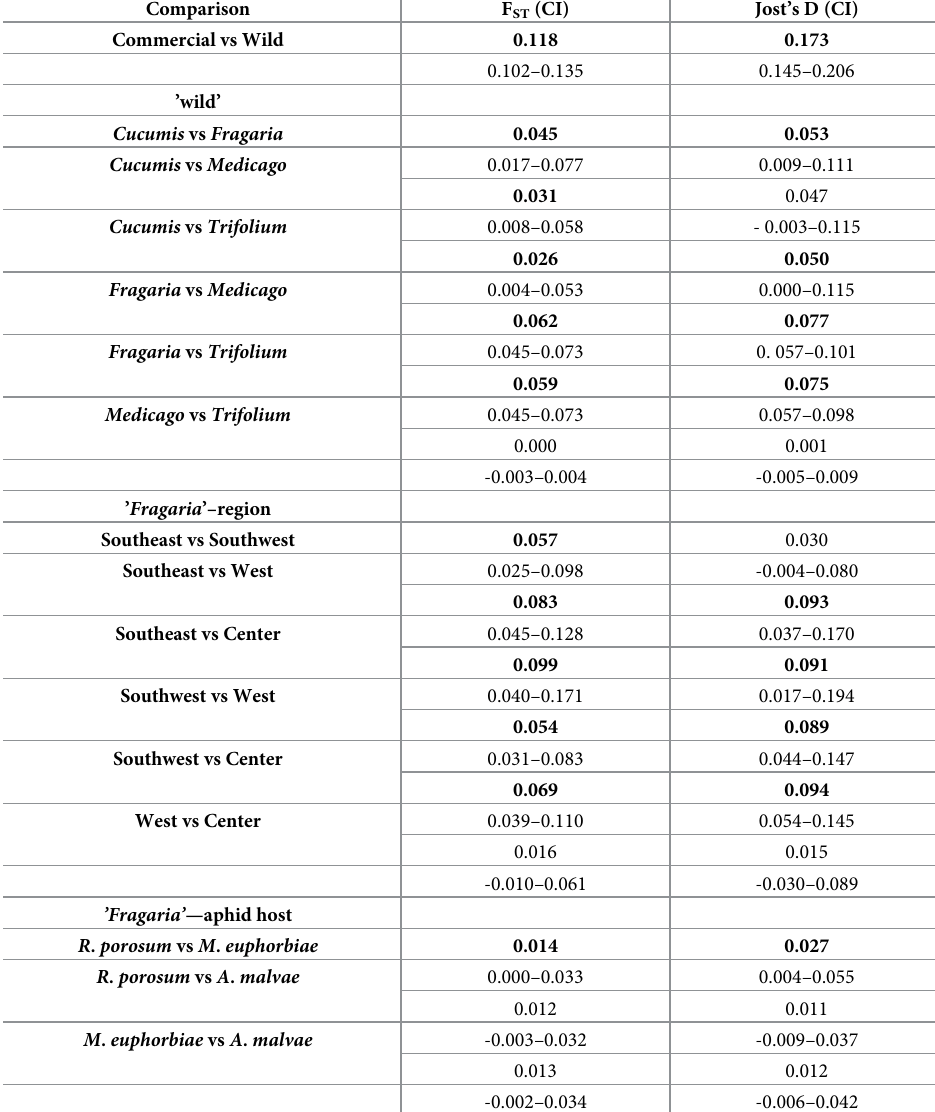
Table 3. Genetic differentiation between putative populations and subpopulations of Aphidius ervi : Pairwise F ST and Jost’s D values based on seven microsatellite loci with Confidence Intervals (CI).